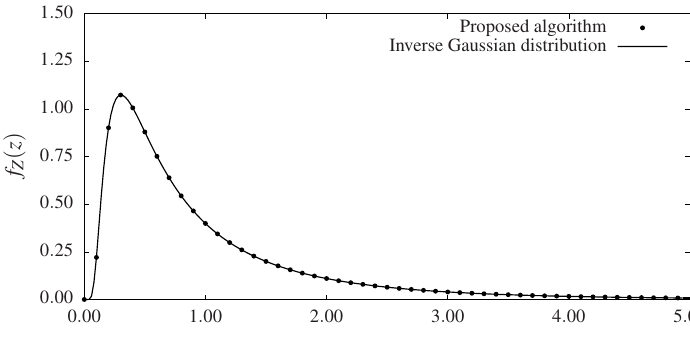
Figure 4 - Comparison between the proposed algorithm and the inverse Gaussian distribution, using α = 1/2 , θ = –1/2